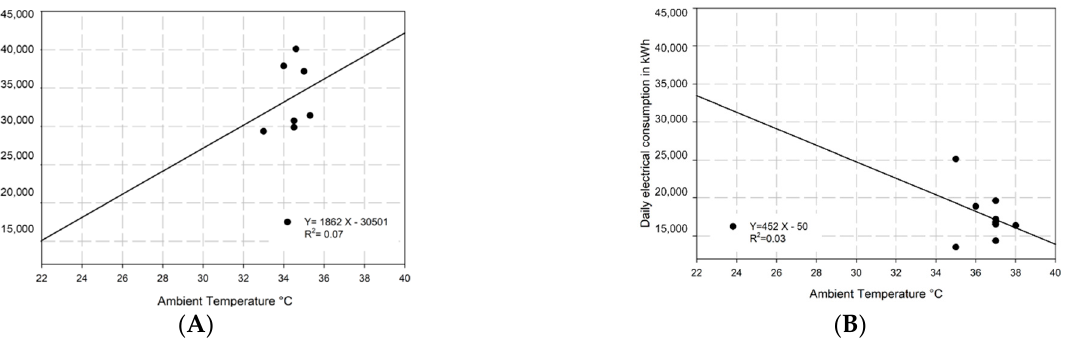
Figure 7. Different linear relationships between ambient temperature and measured electrical con- sumption in the UJ campus for Mondays in different intervals B and C from Table 2. ( A ) Mondays in Summer holiday from 6 May 2019 to 26 August 2019 (Interval B); ( B ) days in Eid Alfitr holiday including two Mondays, 30 May 2019 to 8 June 2019 (Interval C).